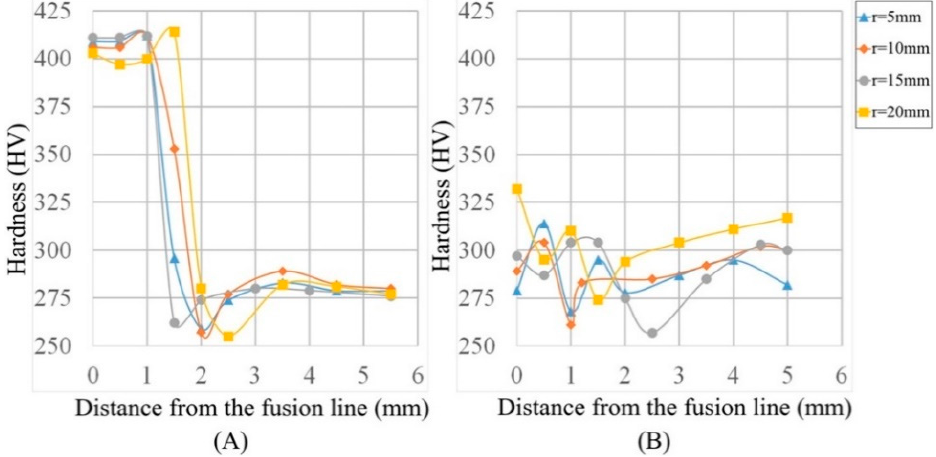
Figure 7. Microhardness variation in HAZ sub-zones of S700MC ( A ) virgin and ( B ) cold-formed sides. Reprinted with permission from ref. [105]. Copyright 2019, Elsevier.